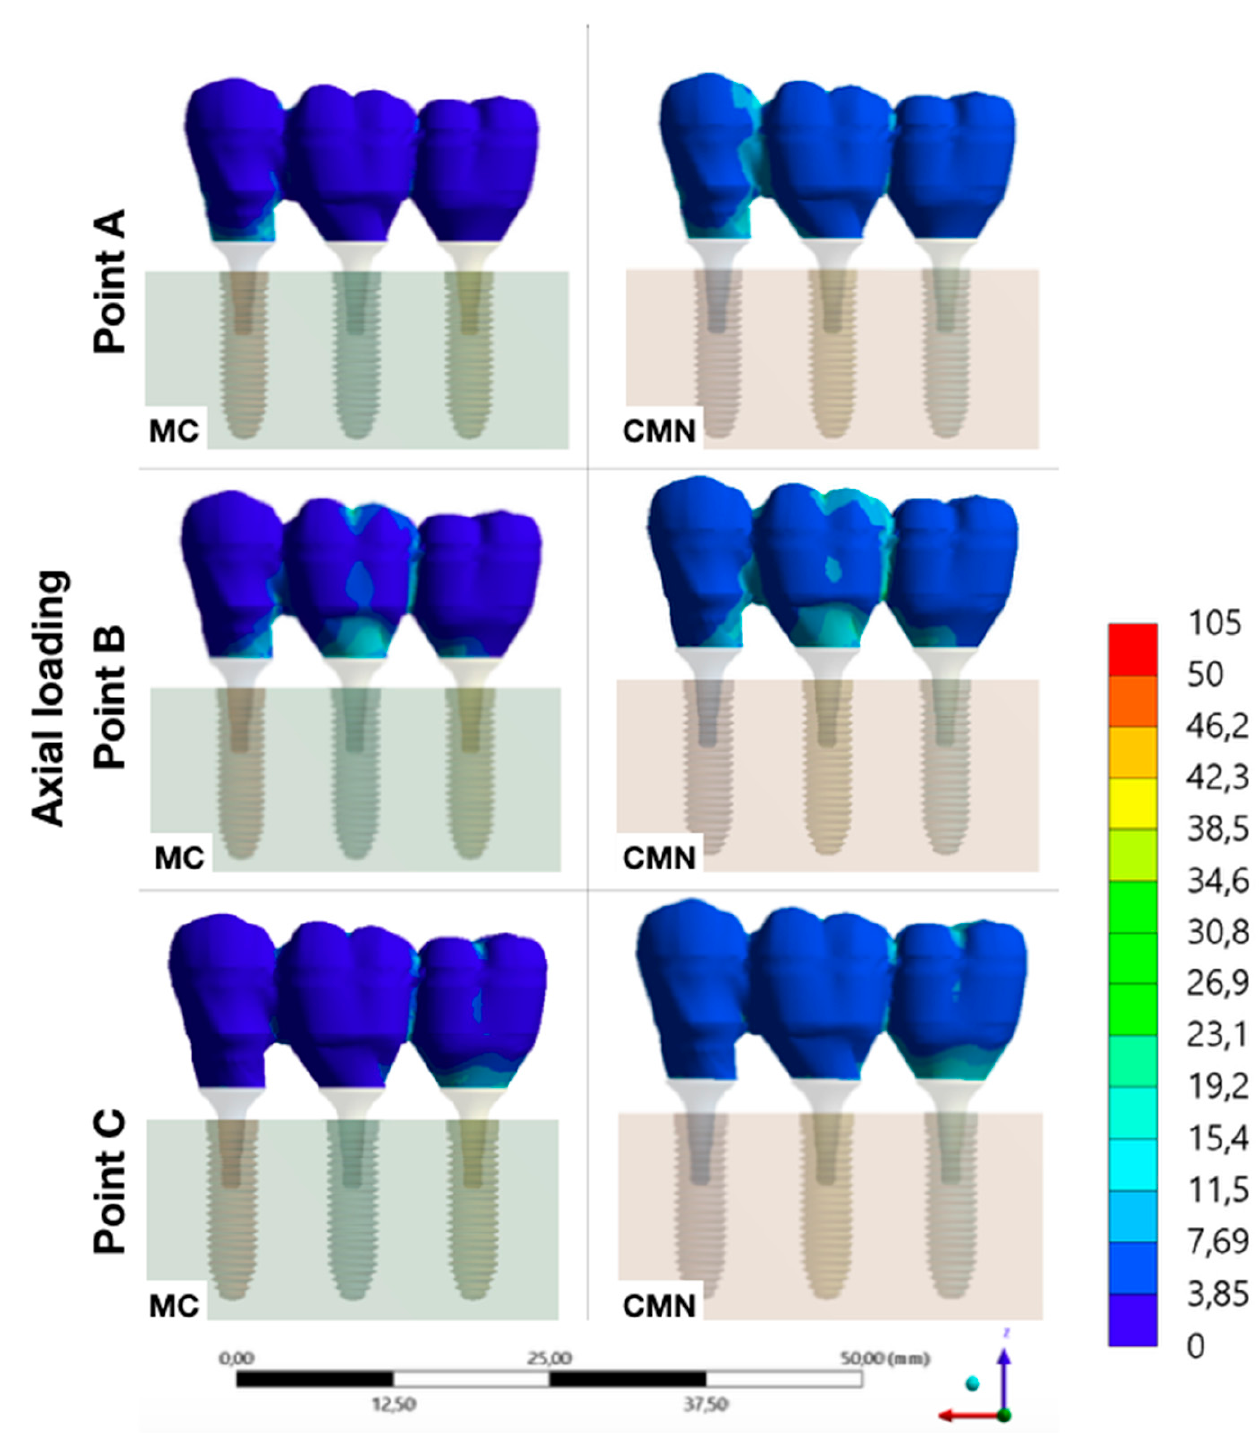
Figure 7. Maximum principal stress (MPa) at the prosthesis for the load application at points A, B, and C (CMN and MC groups).